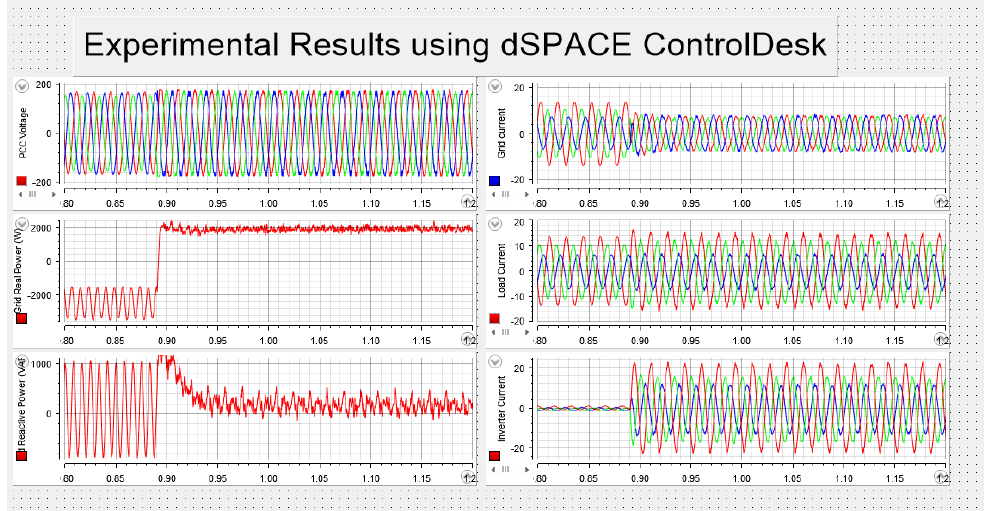
Figure 13. Experimental results at P = 2 kW, Q = 0 var, using dSPACE Control desk.